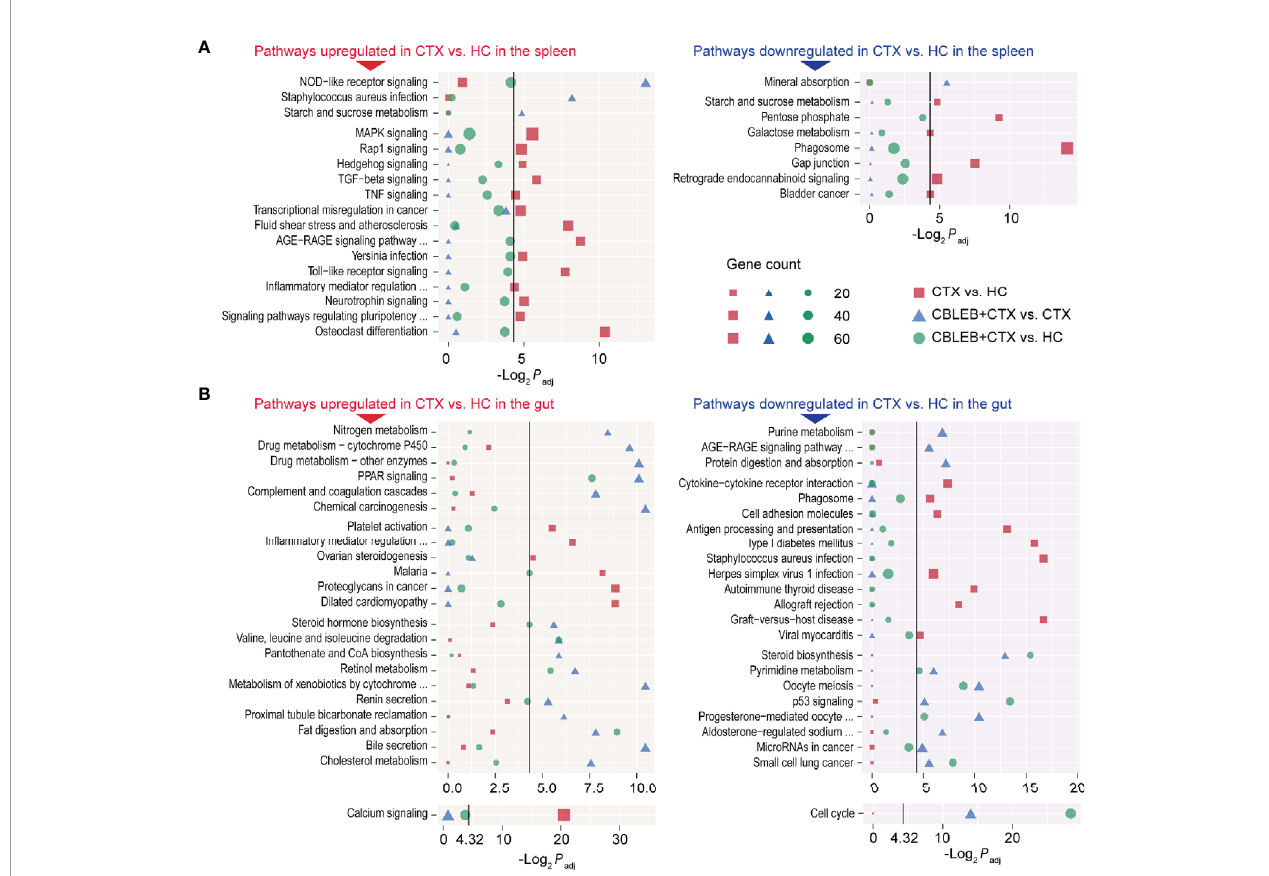
FIGURE 5 | Pathways altered by cyclophosphamide and alleviated by CBLEB in the spleen and colon. (A) Pathways upregulated or downregulated by cyclophosphamide and alleviated by CBLEB in the spleen. (B) Pathways upregulated or downregulated by cyclophosphamide and alleviated by CBLEB in the colon. (n = 3 in all groups; black vertical lines represent -Log 2 P adj = 4.32 corresponding to P adj =